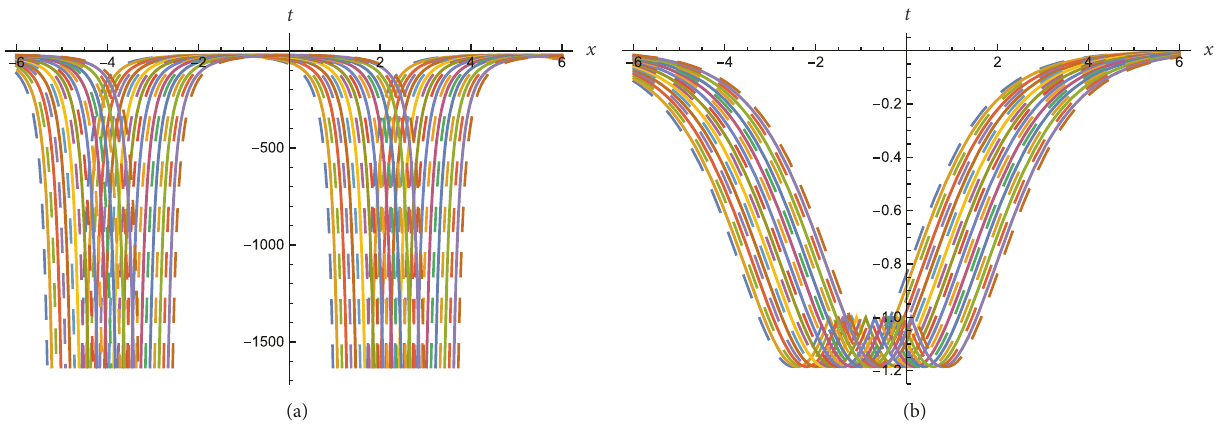
Figure 8: Plot of the exact traveling wave solutions of (a) periodic solitary wave solution (43) with parameters 𝑎 1 = 9;𝛼 = 0.6;𝑙 2 = −1;𝑙 3 = −1;𝜅 = 0.7;𝑐 = 0.1;𝑦 = 0.8 ; (b) dark solitary wave solution (45) plotted at 𝑎